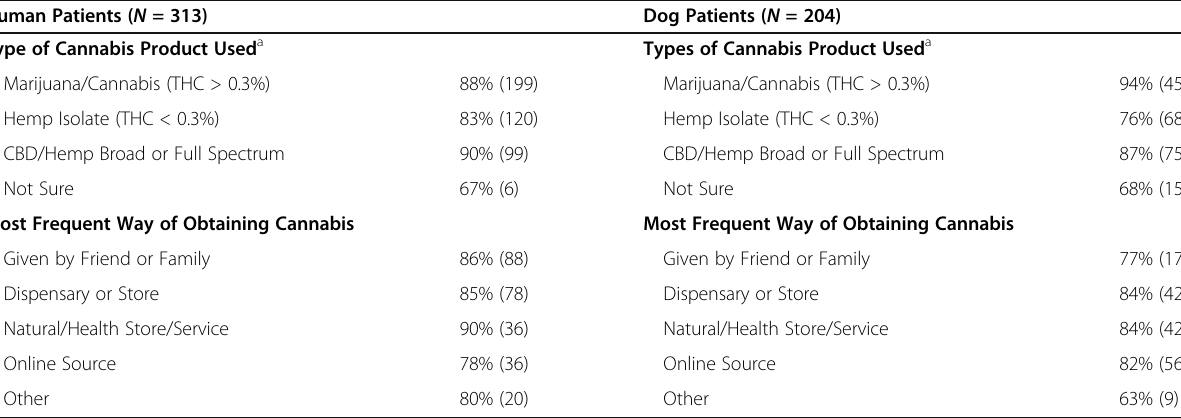
Table 6 Percentages of Respondents Who Felt their Expectations were Met by Cannabis Products Used and Obtained Human Patients ( N = 313) Dog Patients ( N = 204) Type of Cannabis Product Used a